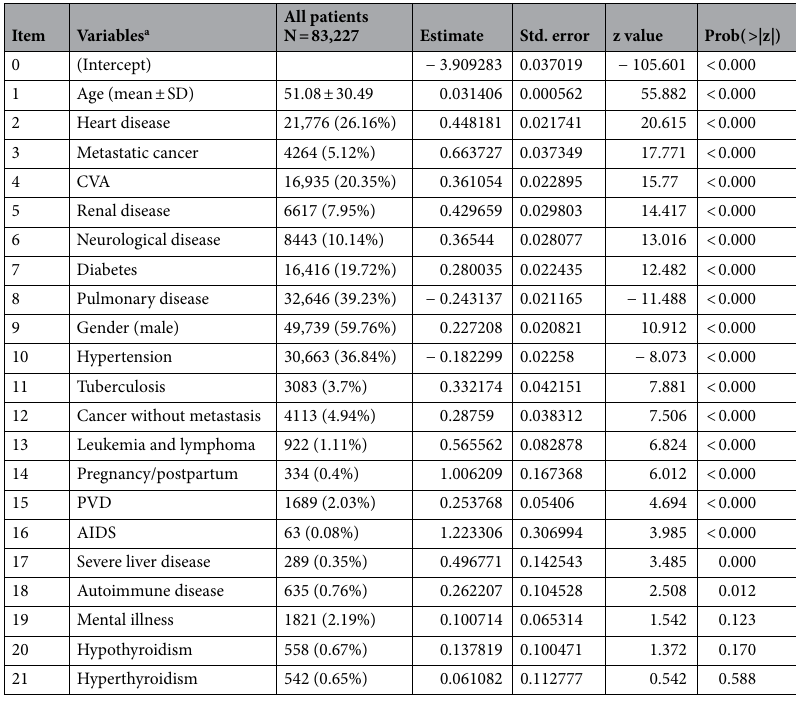
Table 1. Results of the first-stage feature selection by logistic regression. CVA cerebrovascular accident, PVD peripheral vascular disease, AIDS acquired immune deficiency syndrome.